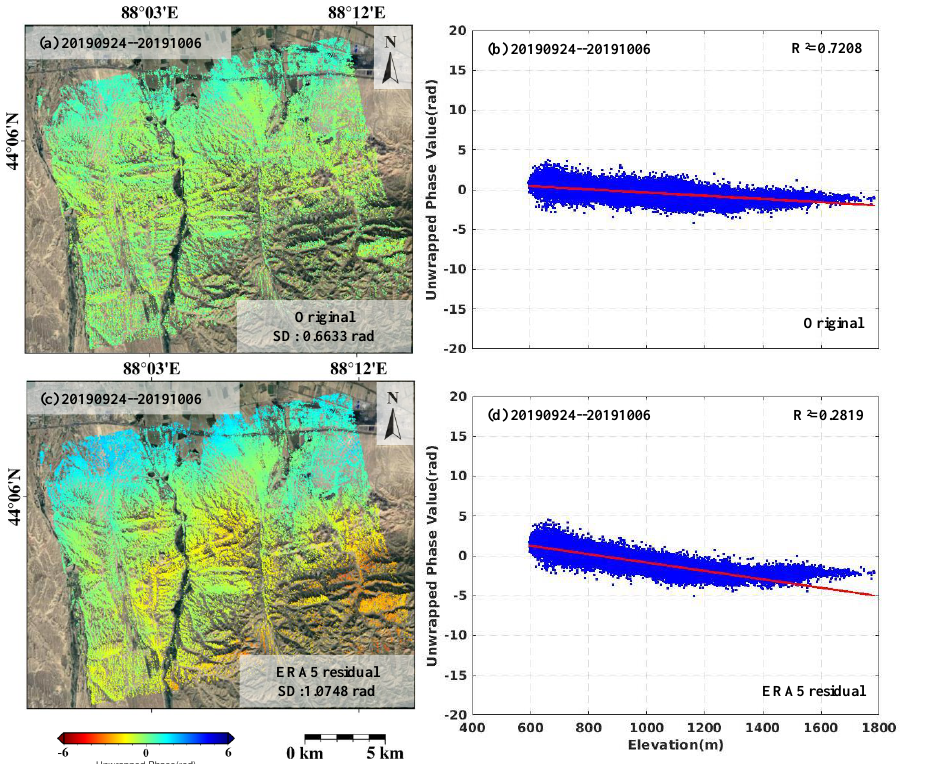
Figure 8. ( a , c ) show the original and residual phase, respectively, of the interferogram 20190924– 20191006. ( b , d ) show the distribution relationship between the corresponding phase and elevation,